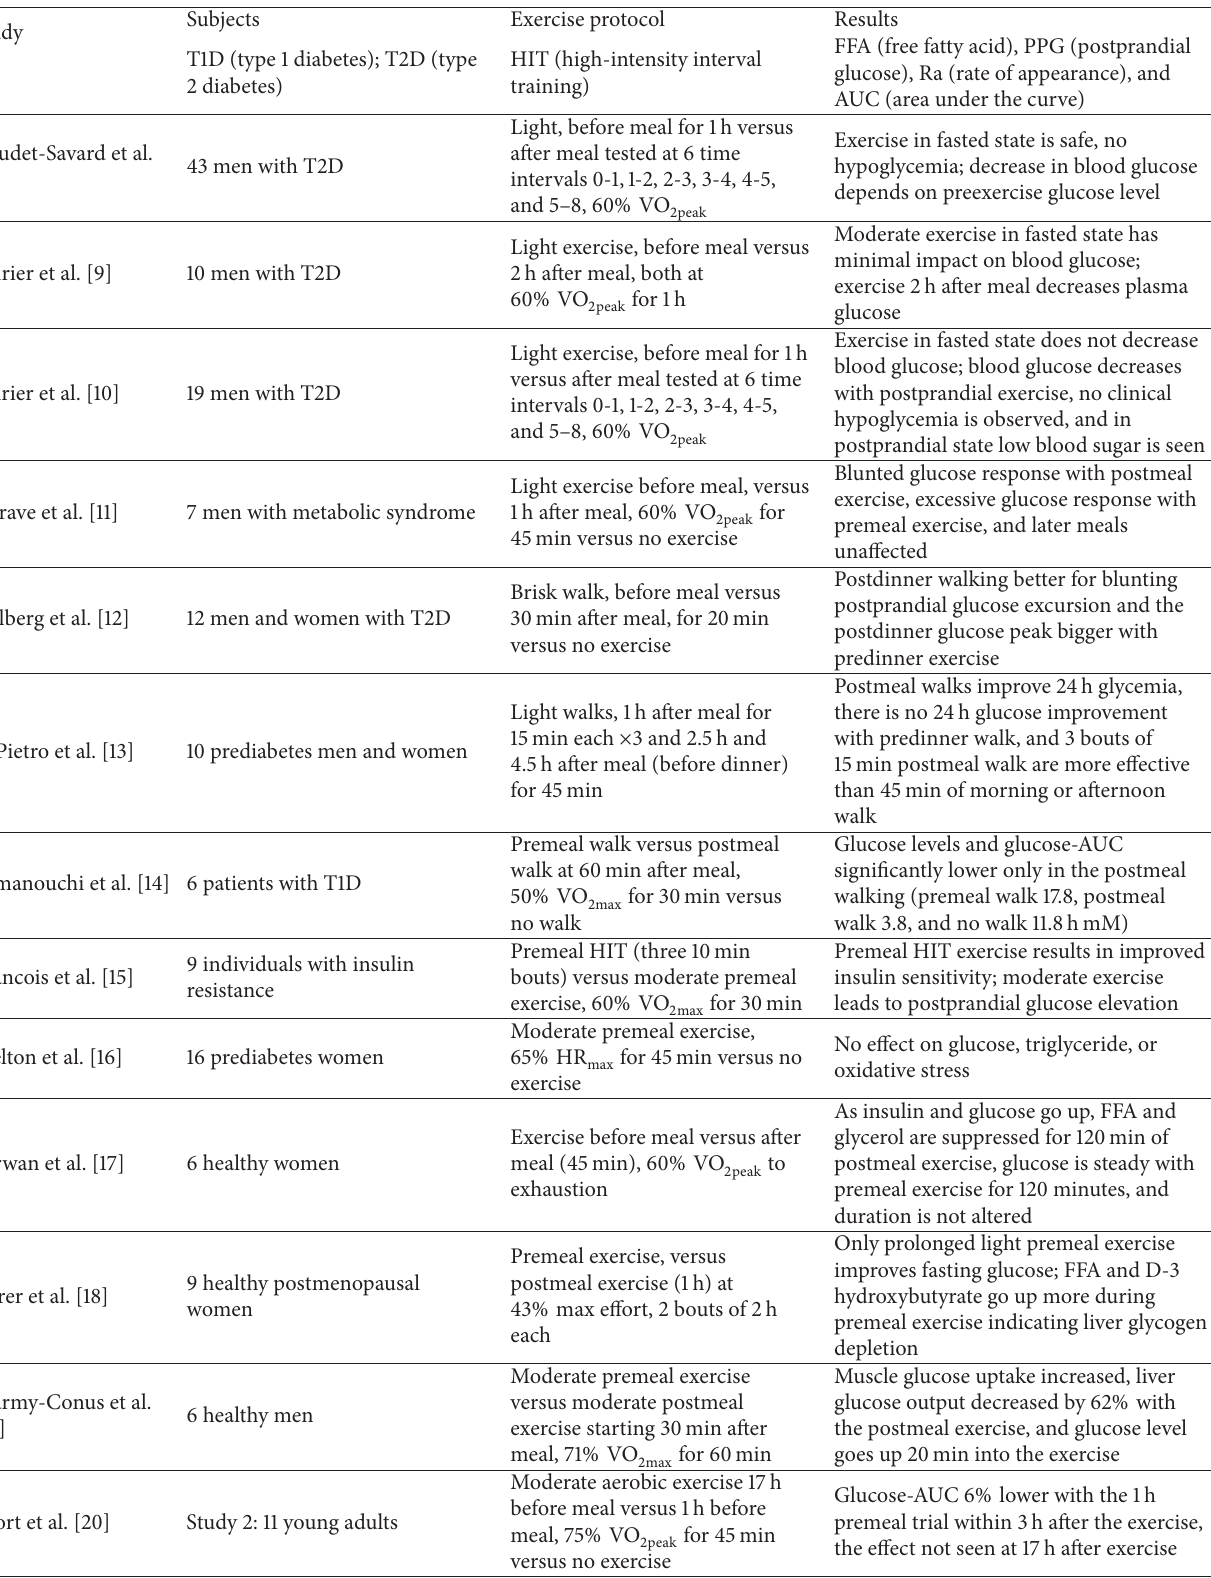
Table 1: Glucose response to different exercise conditions: moderate exercise, before meal [8–21] and after meal [22–30]; high-intensity exercise, before meal [31–34] and after meal [35–39]; comparisons of training, fast versus fed [40–43], timings [44, 45], and durations